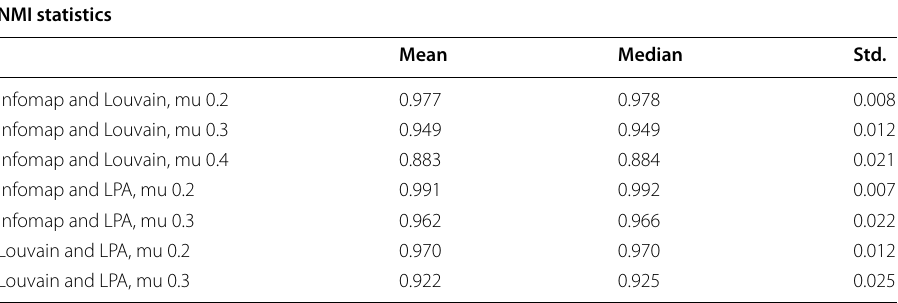
Table 2 Statistics on the normalised mutual information scores for two algorithms on graphs of the same µ